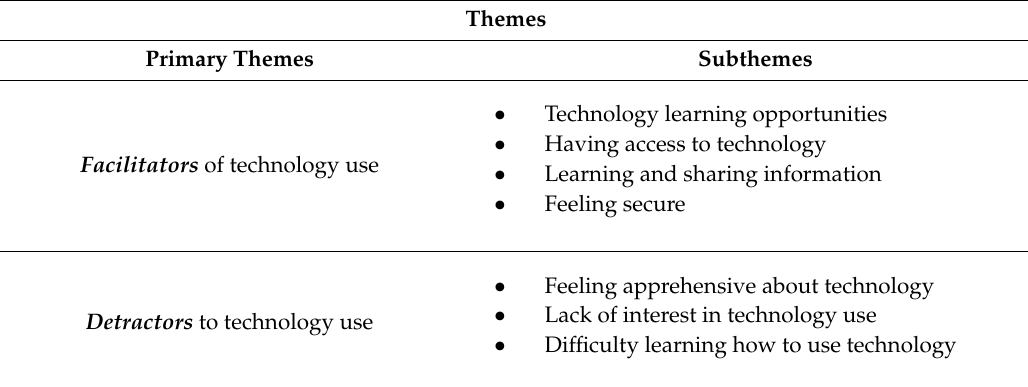
Table 9. The facilitators and detractors of technology